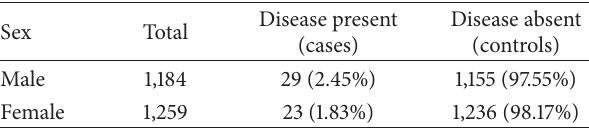
Table 3: Factor of sex on expression of disease. Sex